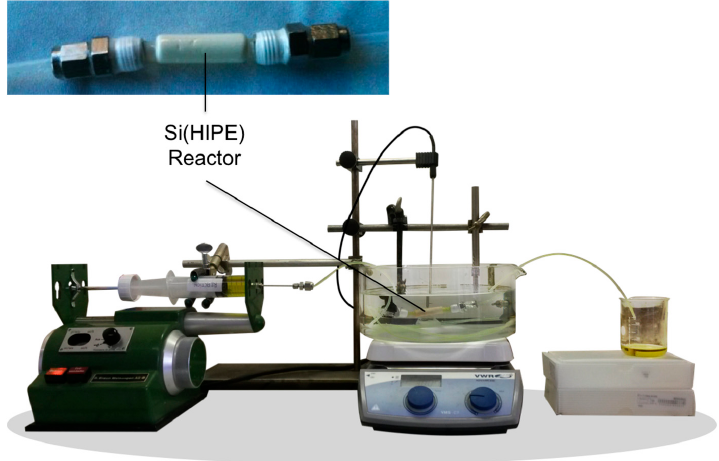
Figure 6. Si(HIPE) monolith placed in a heat-shrinkable PTFE tube. Monolithic reactor is connected to syringe-pump and immerged in a water bath.